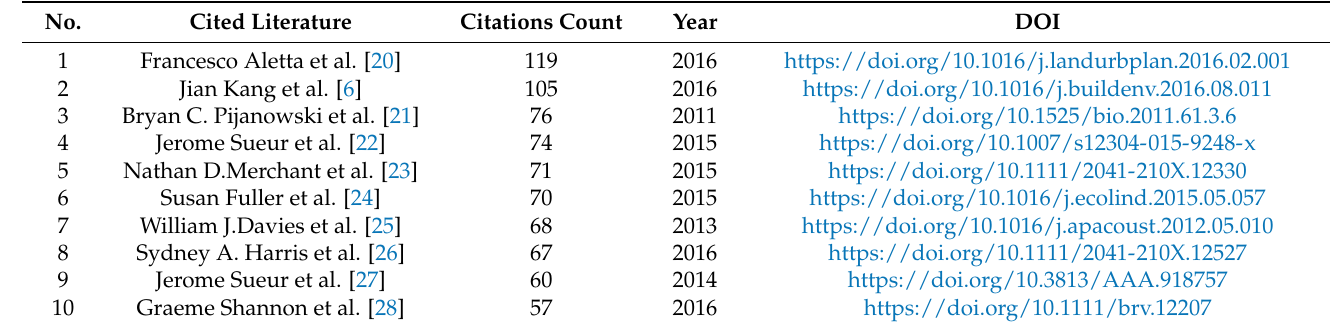
Table 3. Top 10 most-cited literature studies in the field of